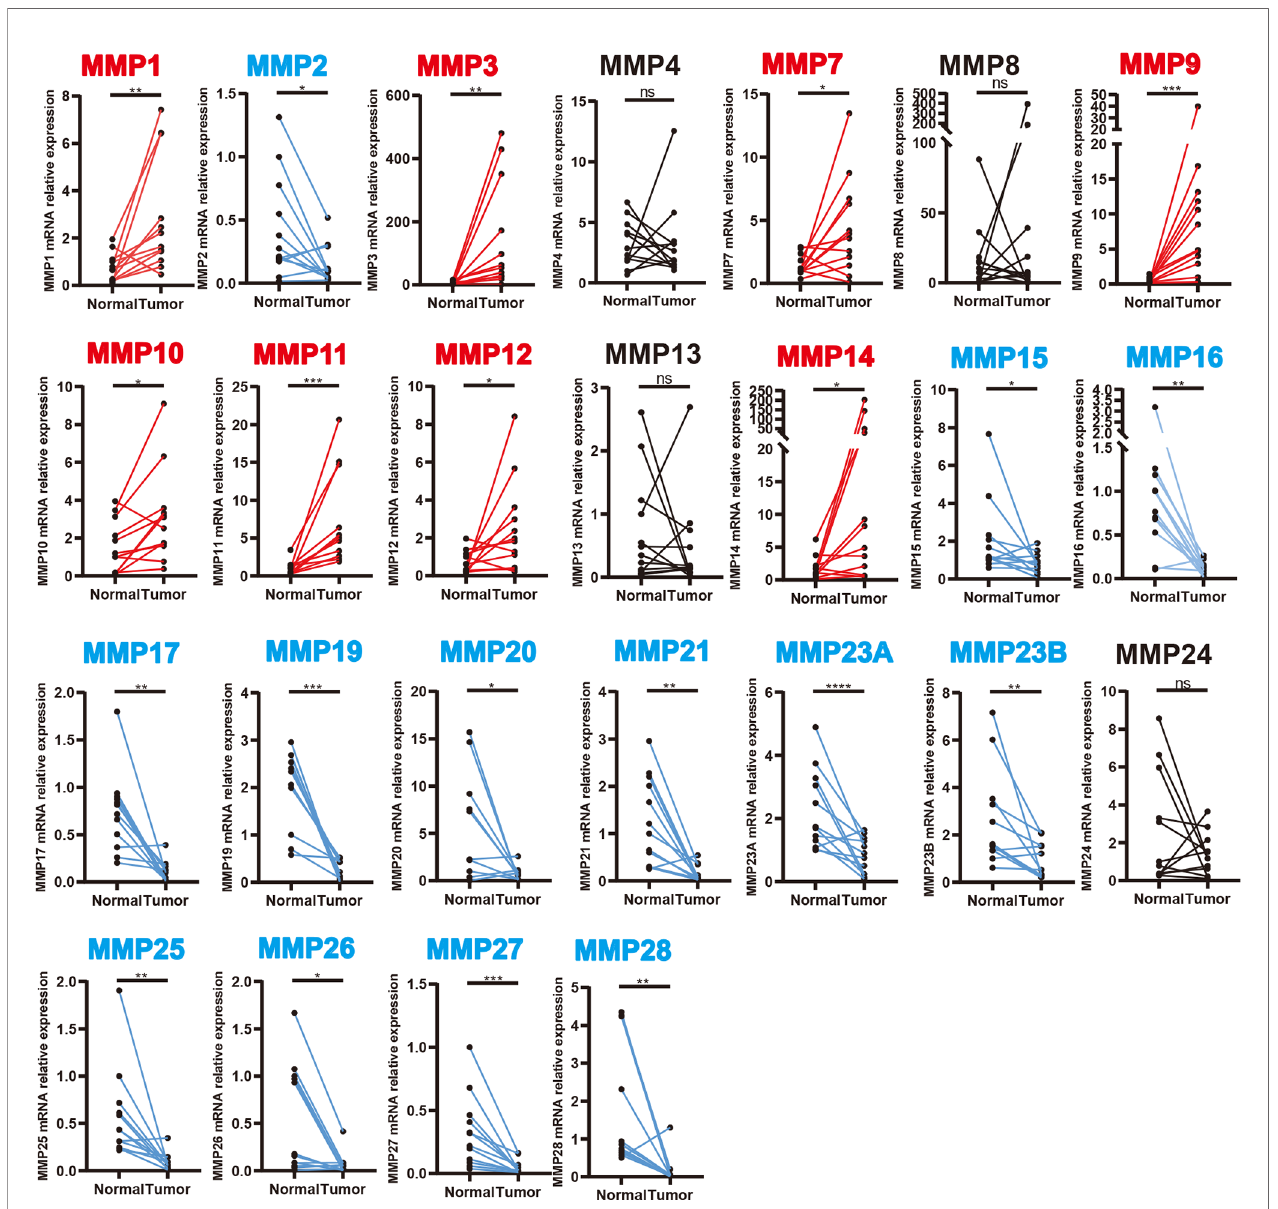
FIGURE 3 | Transcription levels of MMPs in colorectal cancer tissue and adjacent normal tissue (12 colorectal cancer patients in our hospital). Signi fi cant records are denoted by the red asterisk on top of the plot ( ns p > 0.05, * p < 0.05, ** p < 0.01, *** p < 0.001 and **** p < 0.0001). Upregulated records are highlighted in red, while downregulated records are highlighted in